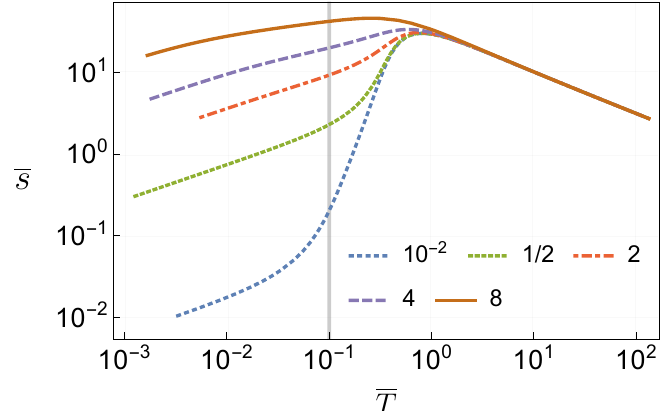
Figure 15 . Entropy density as a function of temperature for various values of the charge density √ 2 N q